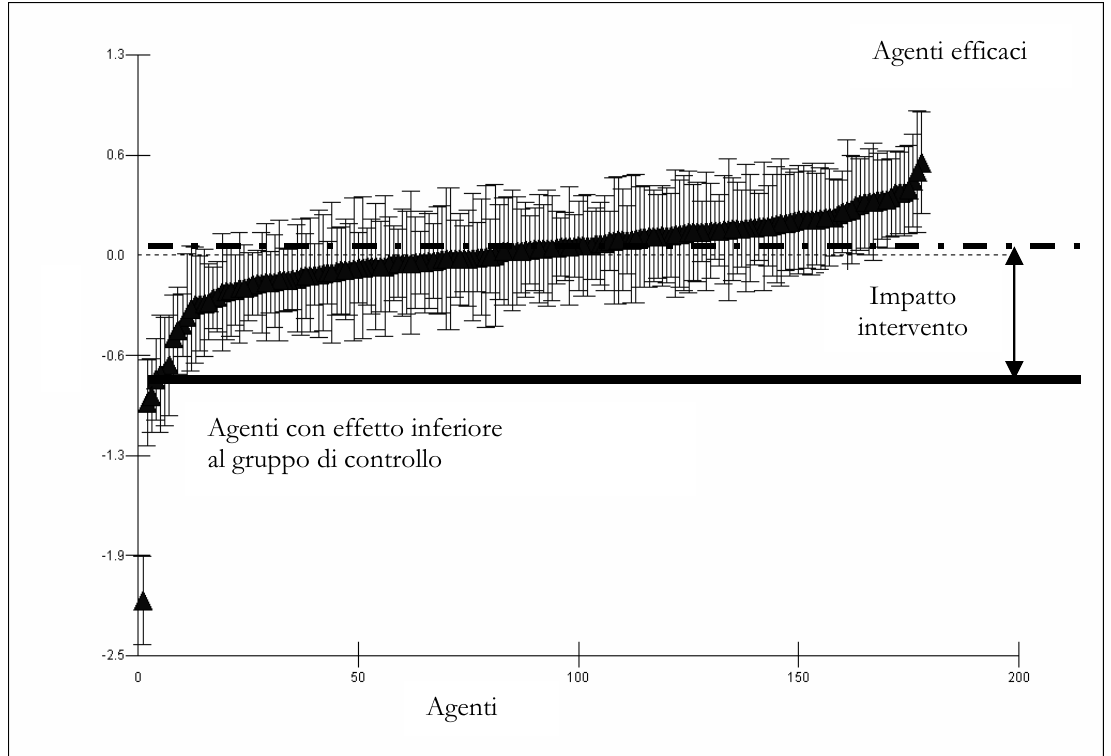
Figura 1 – Effetto degli Agenti in ambito relativo e di efficacia di impatto.